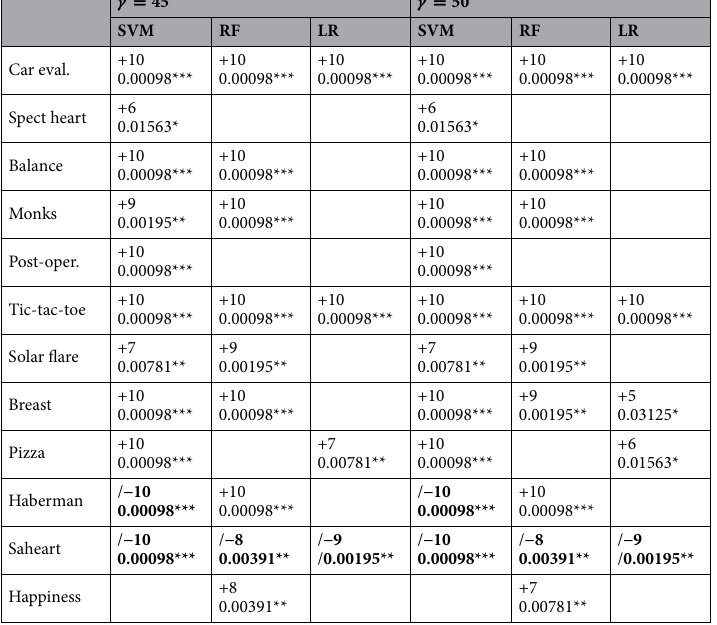
Table 12. Analogous to Table 8 but with γ = 45, 50